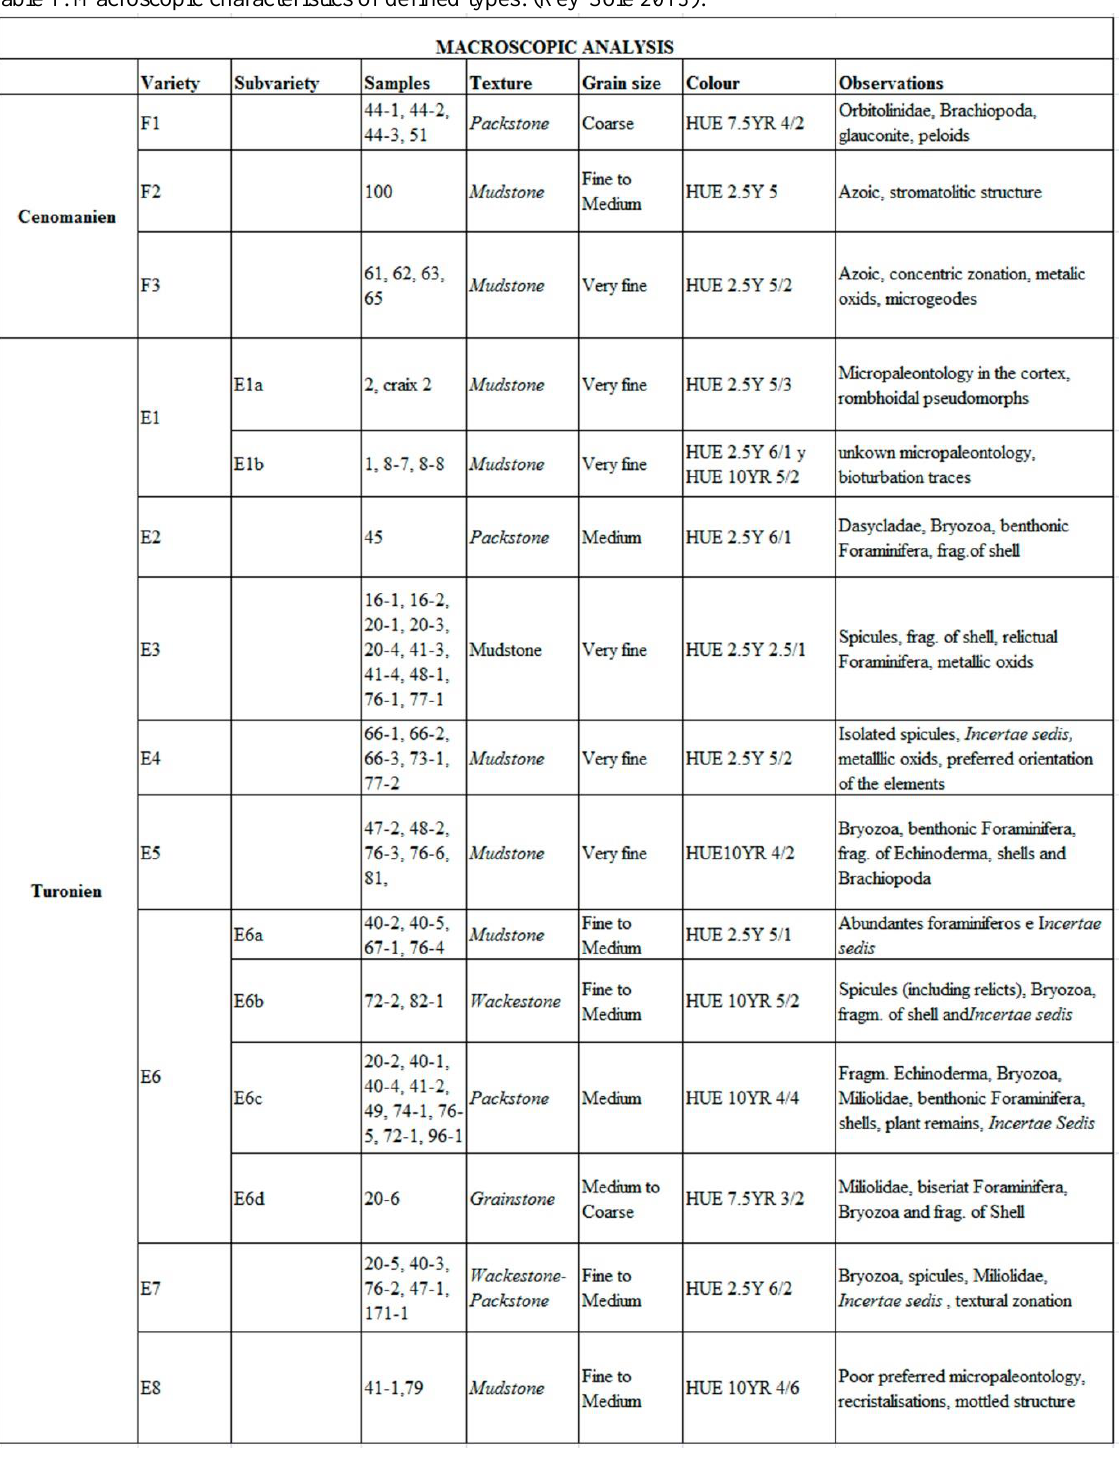
Table 1. Macroscopic characteristics of defined types. (Rey-Solé